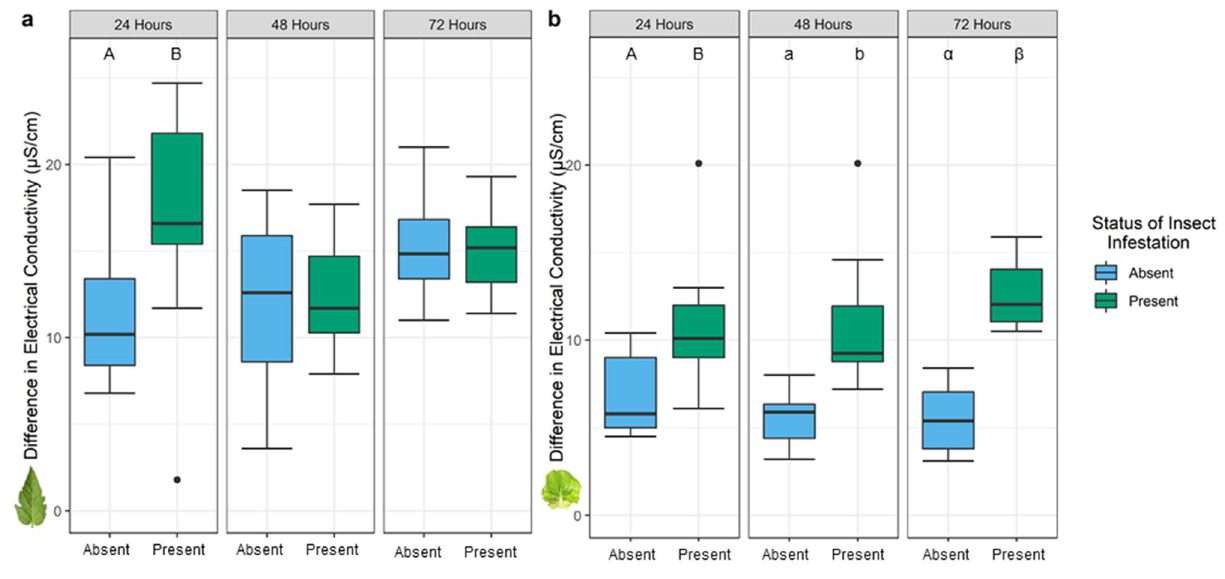
Figure 1. Infestation by Macrosteles quadrilineatus leads to an increase in measured cellular damage on tomato ( a ) and lettuce ( b ) leaves. When compared to uninfested areas, electrolyte leakage was significantly higher on tomato leaflets ( a ) infested for 24 h, and on lettuce leaves ( b ) infested for 24, 48, and 72 h ( P < 0.05). Three clip cages were fastened onto a middle leaf each containing one leafhopper (green), and additional three clip cages remained empty (blue) on an opposing leaf. Electrical conductance was calculated by subtracting the final from the initial measurement for damaged and undamaged leaf discs and were used to evaluate the extent of electrolyte leakage over six hours. Letters above boxplot indicate significant differences between treatment groups within a single time point ( P < 0.05). A student’s t-test was used to assess significance between samples from infested or non-infested clip cages. Singular dots represent an outlier